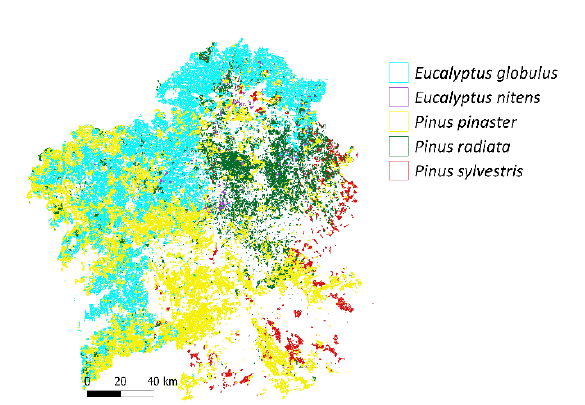
Figure 2. Distribution of the main productive tree species in Galicia according to the Spanish Forest Map (MFE) (MAPA, 2011).